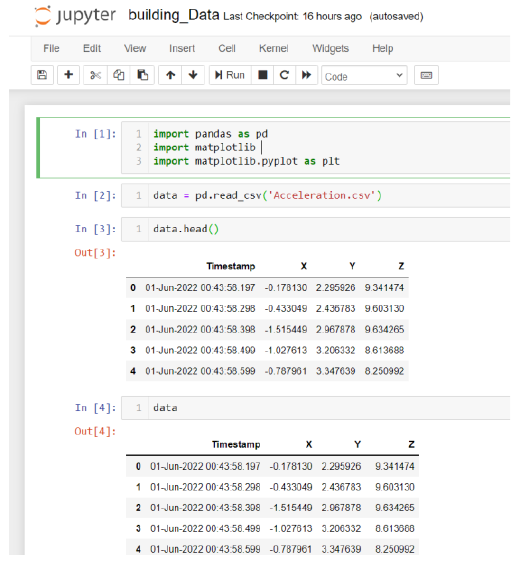
Figure 40. Libraries and dataset.